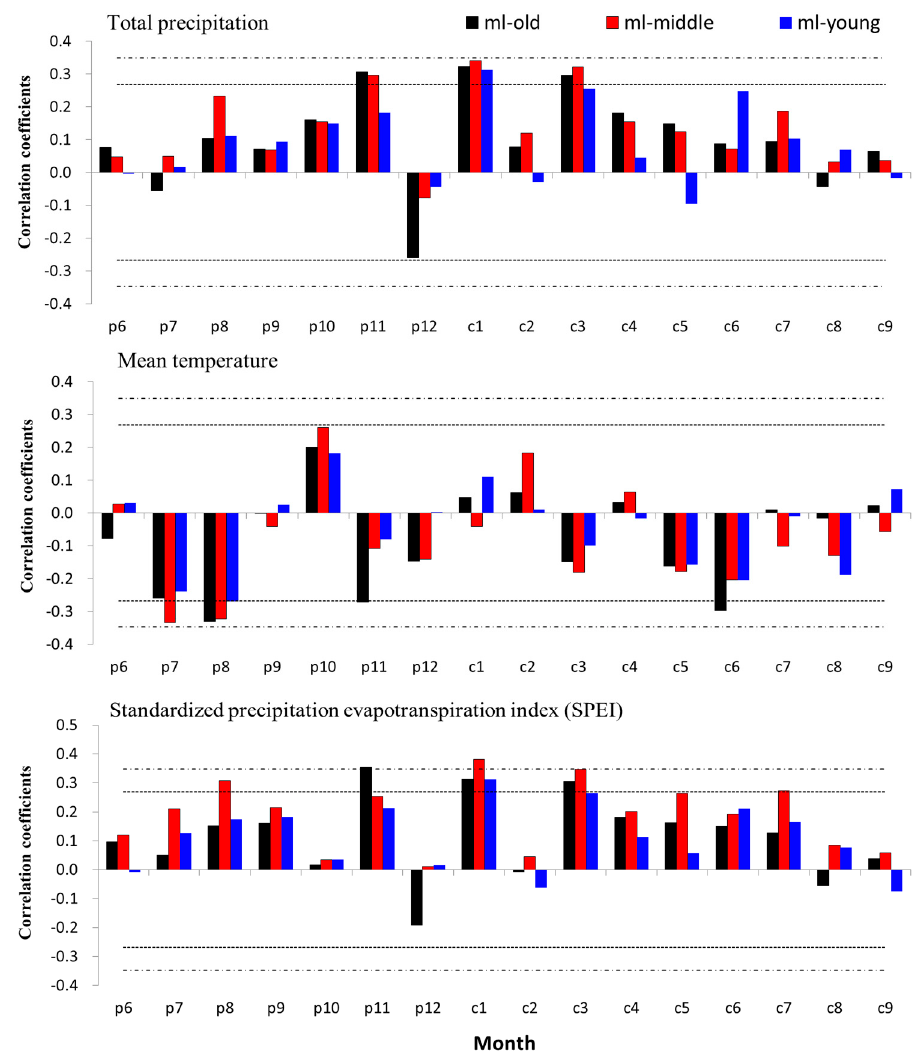
Figure 4. Correlations between tree-ring width chronologies from three age-classes of Schrenk spruce trees and monthly climate factors (total precipitation, mean temperature and SPEI) during 1960–2012 in the eastern Tianshan Mountains (The dotted lines represent significance at the 0.05 level and the straight lines represent significance at the 0.01 level. p: previous year, c: current year, Number: month, e.g., p6 represents June of the previous year and c1 represents January of the current year).